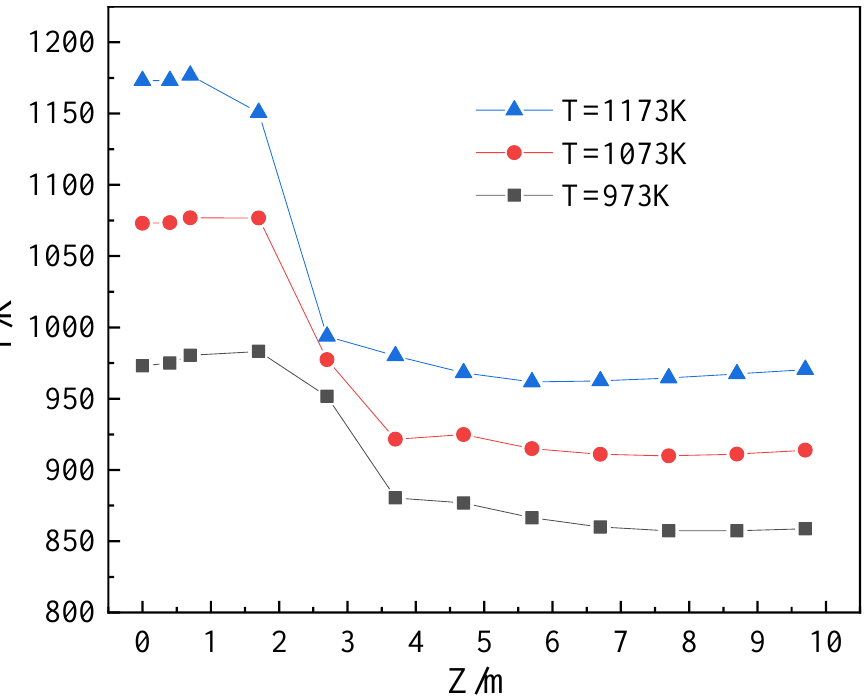
Figure 18. Temperature distribution curve of Z-axis sections of reductor with different flue gas temperatures.